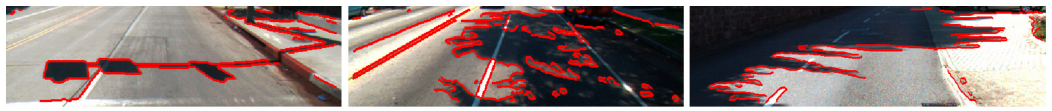
Figure 15. Shadow edge detection results of images in Figure 12 obtained by Property